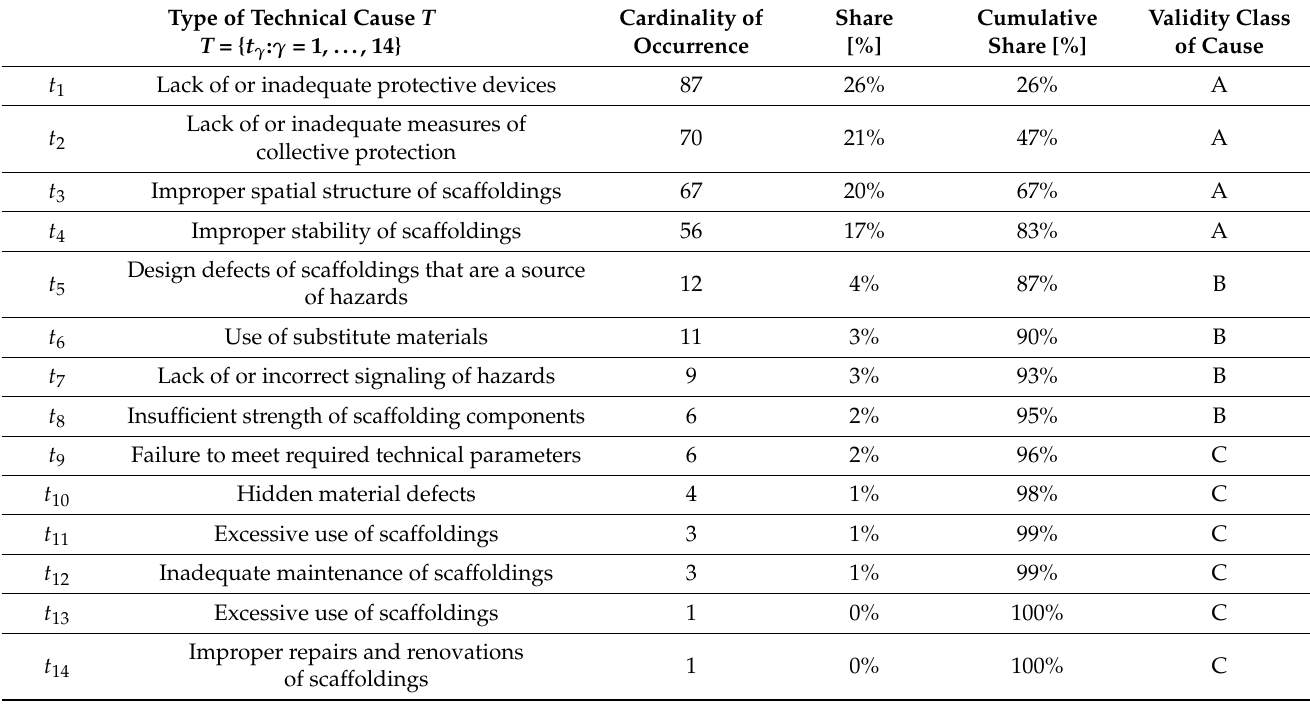
Table 2. Analyzed detailed technical t γ